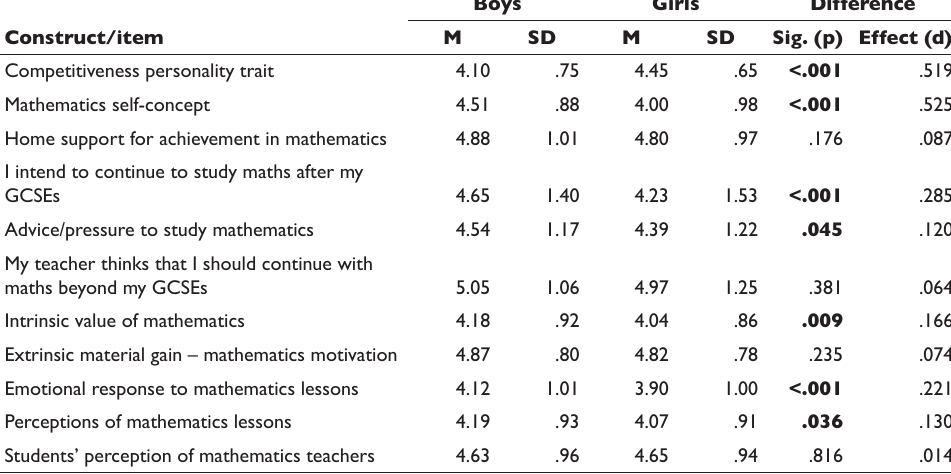
Table 1.2: Londonyear8andyear10students:Surveyresponsesbystudentgender